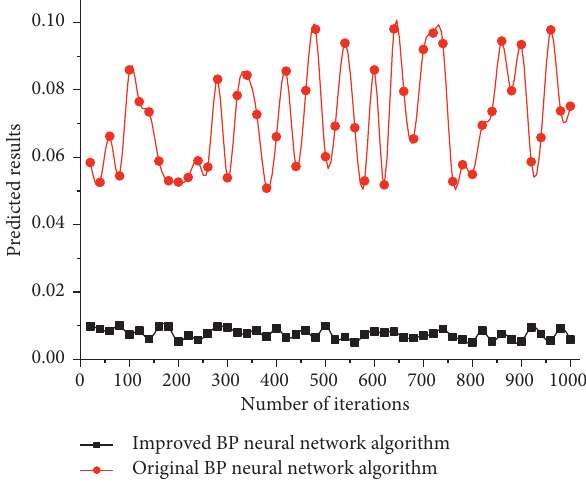
Figure 6: Comparison of prediction results after convergence and smoothing.